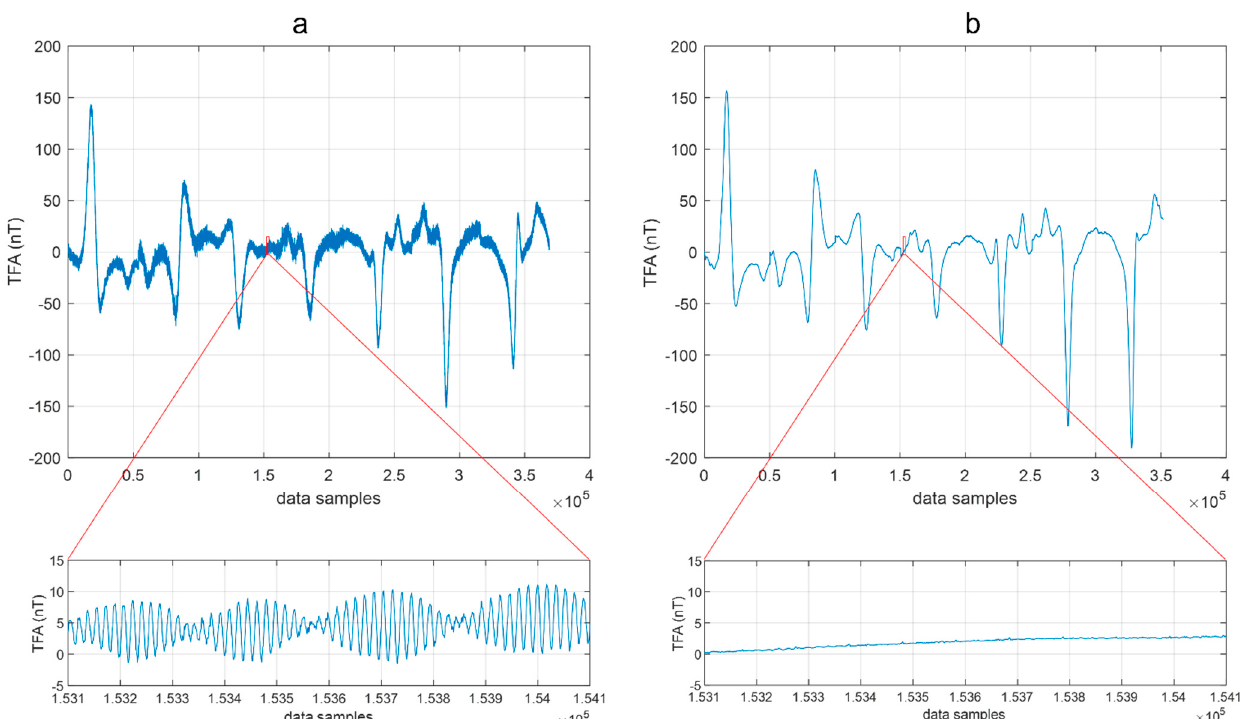
Figure 3. Total-field anomaly acquired using different flight configurations. ( a ) Data acquired with a magnetometer–UAV distance of 0.5 m (F0.5 dataset); ( b ) data acquired with a magnetometer–UAV distance of 3 m (F3.0 dataset). “TFA” stands for “total-field anomaly.”